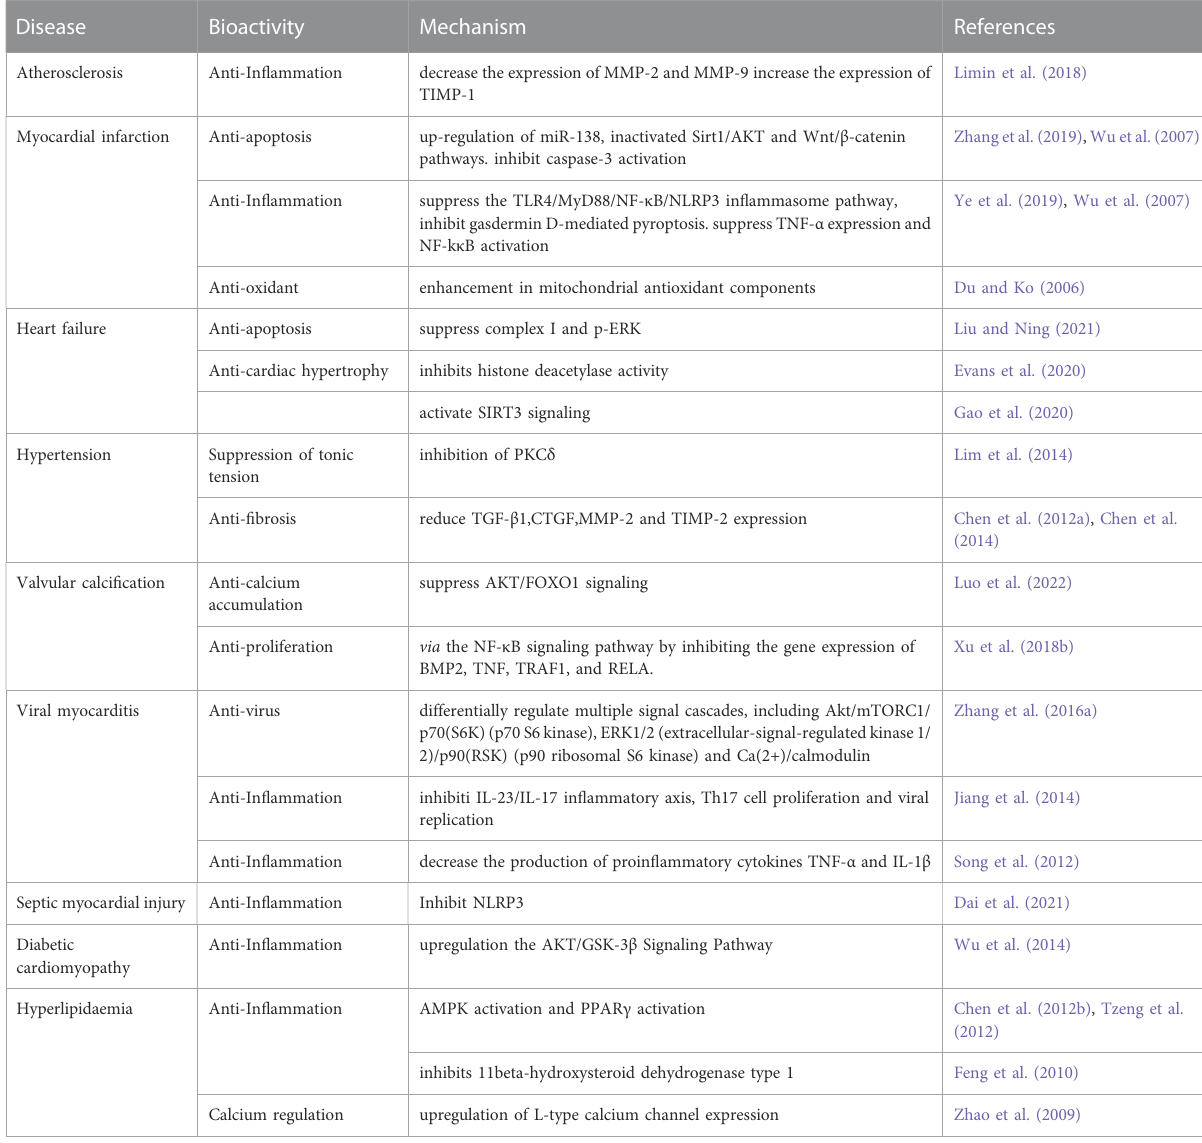
TABLE 1 Role of emodin in cardiovascular diseases.